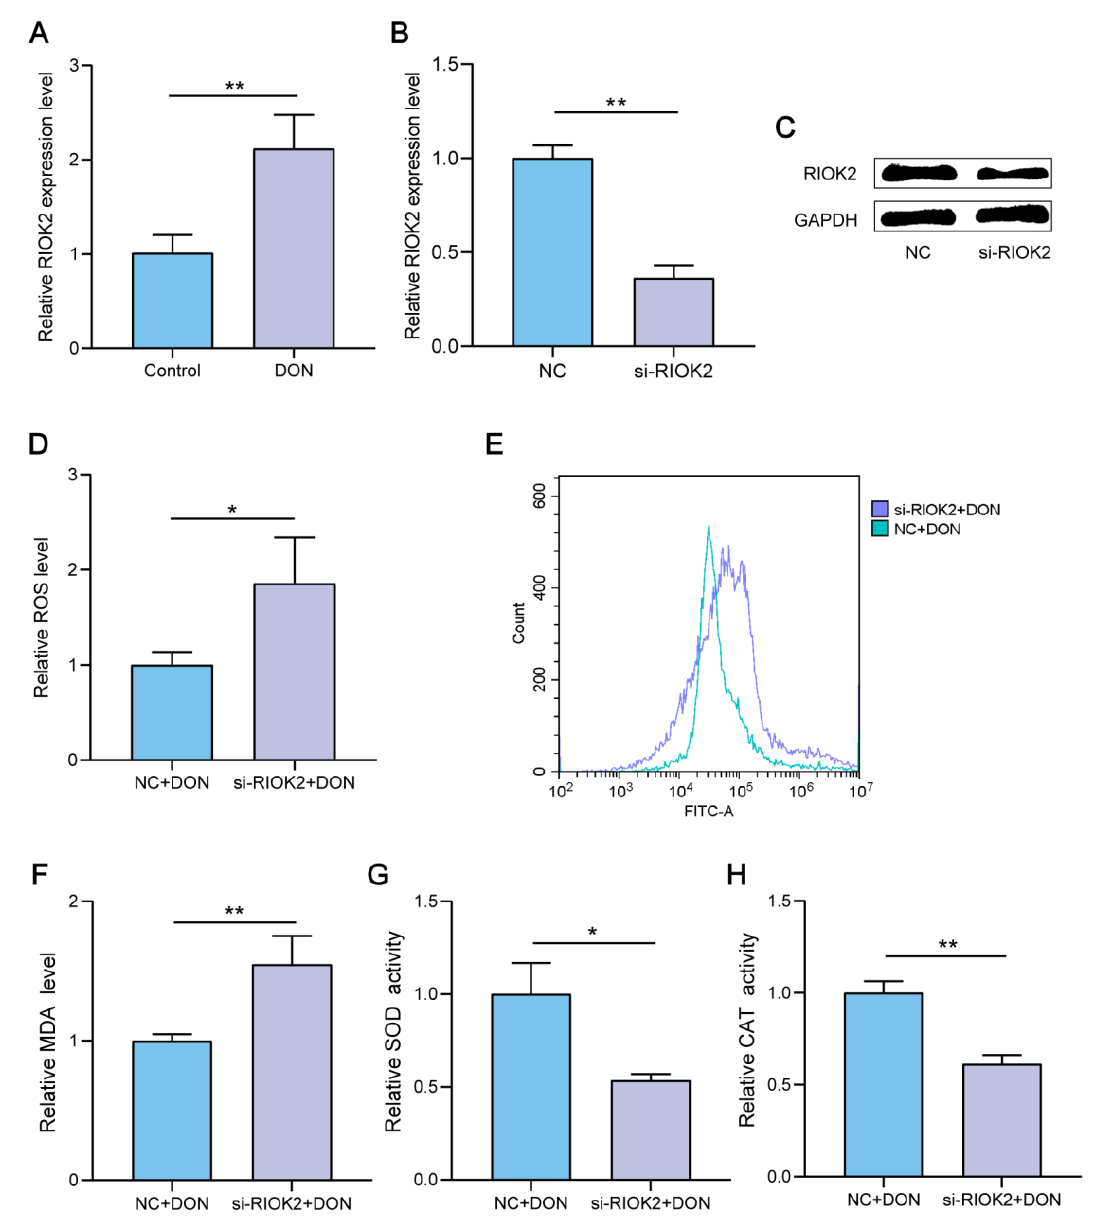
Figure 1. Effects of silencing RIOK2 on oxidative stress markers in DON-induced IPEC-J2. ( A ) RIOK2 mRNA expression levels in DON-induced cells and control cells. ( B , C ) Interference efficiency detection after transfection with siRNAs. ( D , E ) Fluorescence intensities in IPEC-J2 detected by flow cytometry. ( F – H ) MDA level, SOD activity, and CAT activity determined by assay kits. IPEC-J2 were transfected with si- RIOK2 or negative control and treated with DON for 48 h. Each experiment was replicated at least three times, and data are presented as mean values ± SD. * p < 0.05, ** p < 0.01.